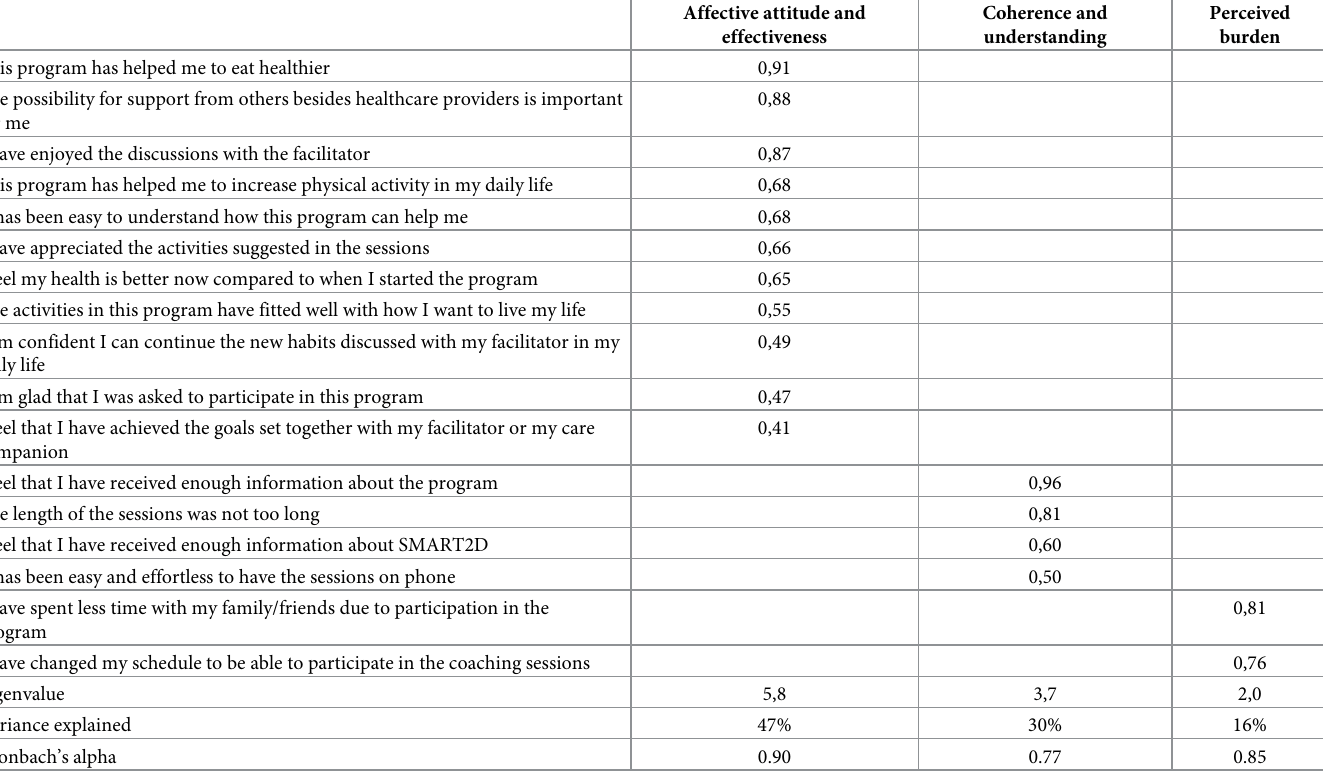
Table 5. Factor loadings from exploratory factor analysis and respective Cronbach’s alpha scores for the final domains.